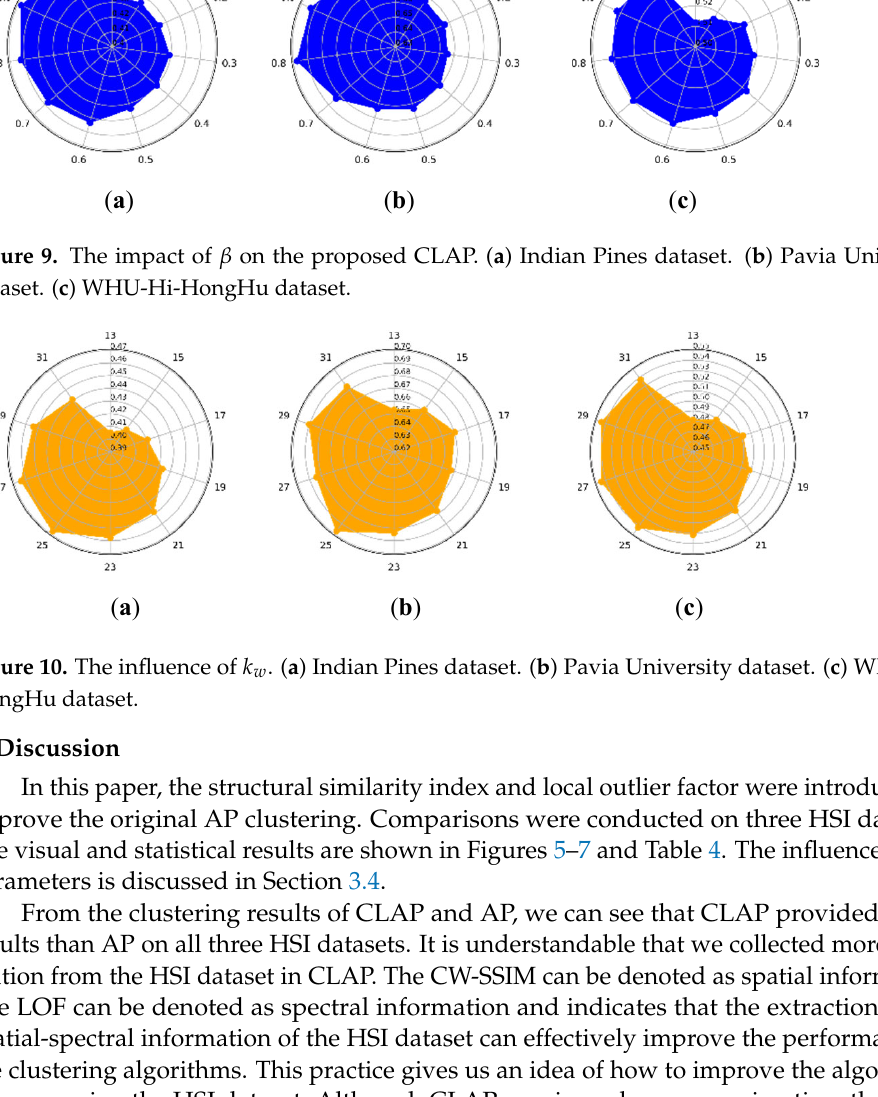
Figure 10. The influence of 𝑘 (cid:3050) . ( a ) Indian Pines dataset. ( b ) Pavia University dataset. ( c ) WHU ‐ Hi ‐ HongHu dataset.